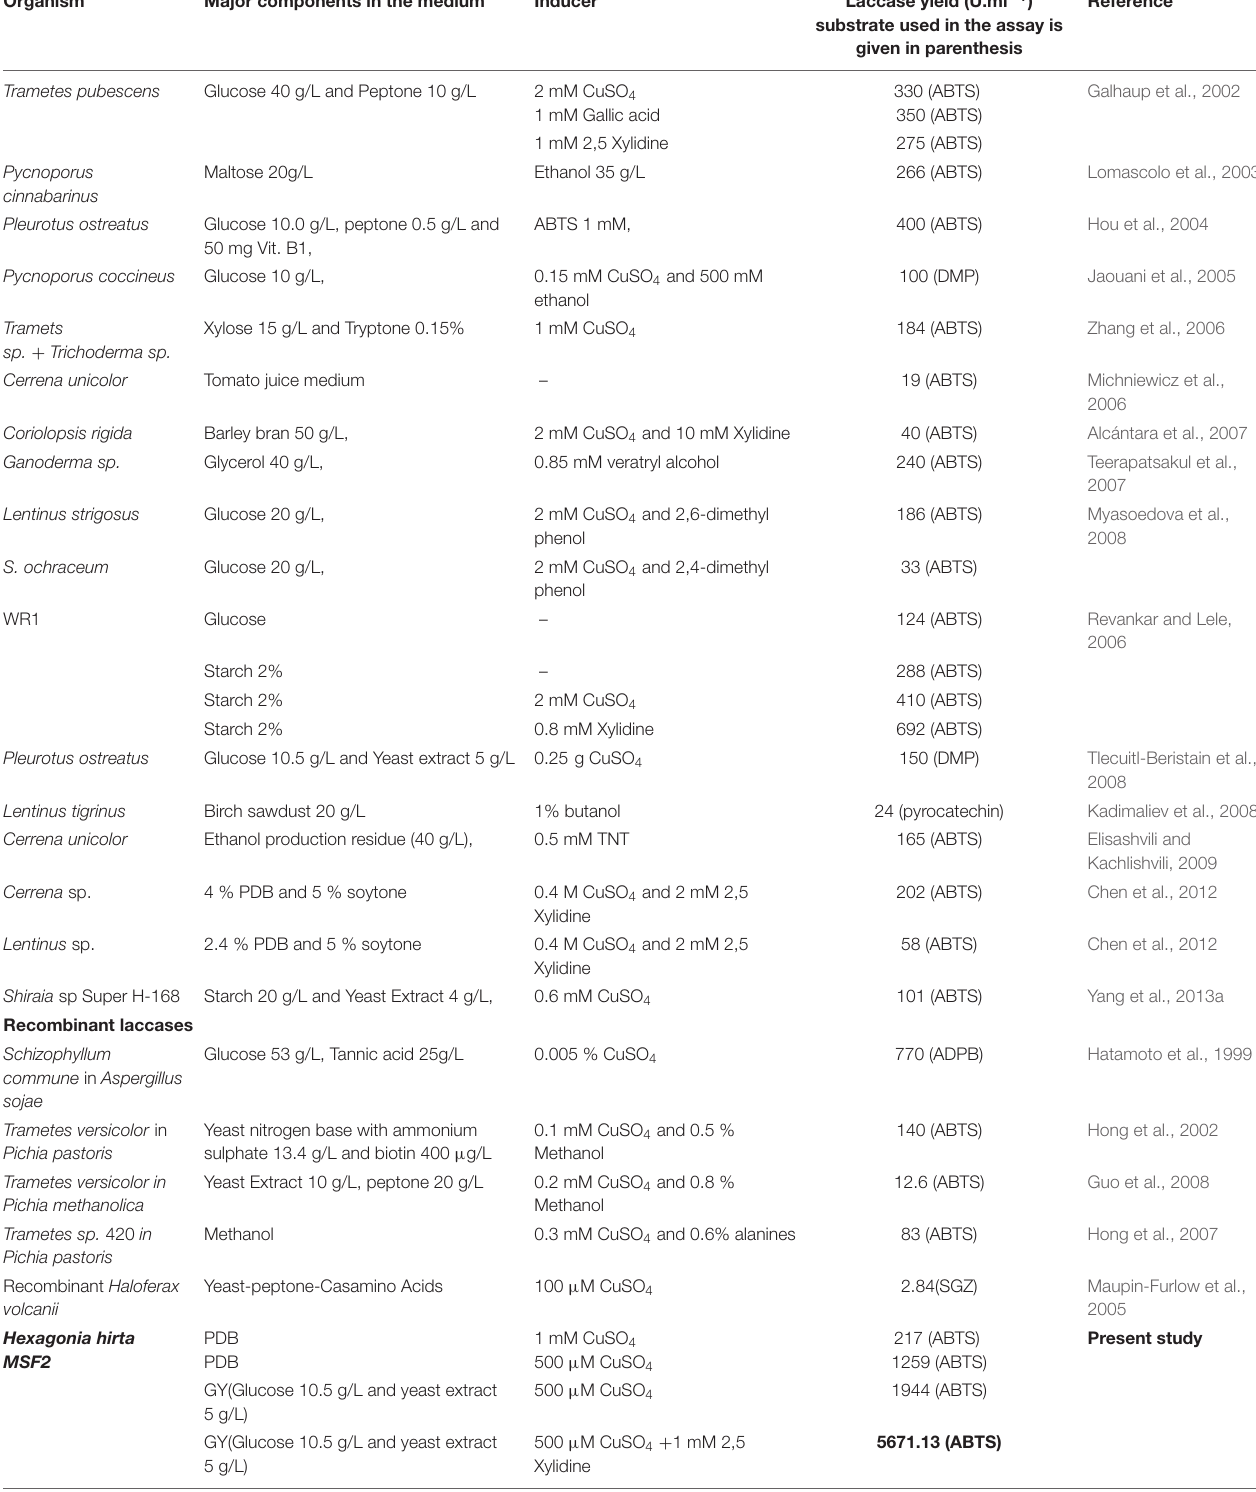
TABLE 1 | Literature comparison of laccase production by various WRB and recombinants. Organism Major components in the medium Inducer Laccase yield (U.ml − 1 )